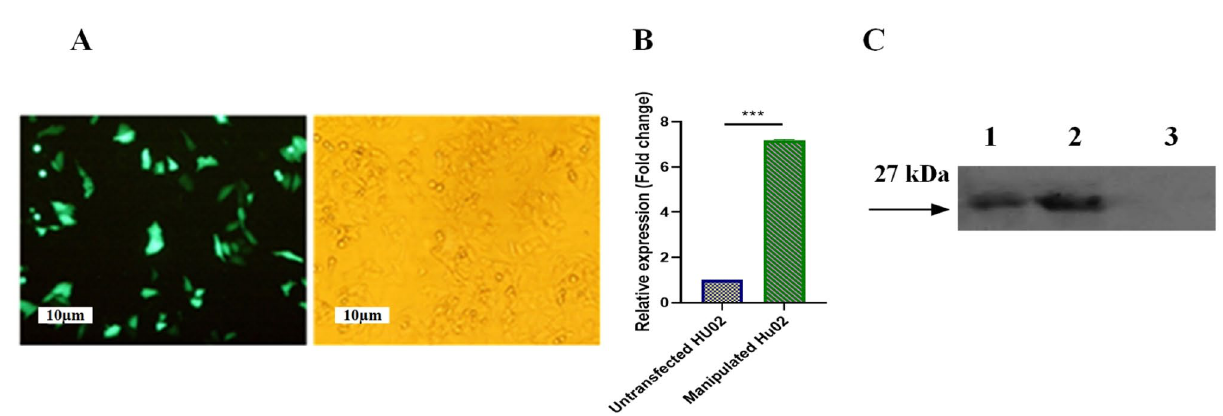
Figure 2. Schematic representation of the expression vector containing targeted gene used in this study and confirmation of VEGF gene by PCR and final approval of cloning by BamHI restriction enzyme. ( A ) pcDNA 3.1 (-) expression vector containing VEGF fragment downstream of the CMV promoter. ( B ) Agarose gel electrophoresis revealed that the PCR amplified target gene fragment was in the expected position, 620 bp of VEGF. ( C ) Cloning confirmation was done from the intermediate vector in the expression vector via BamHI restriction enzyme. Column 1: pcDNA 3.1 (-) containing VEGF vector cut with BamHI enzyme that cut fragment is 620 bp Column 2: The uncut pcDNA 3.1 (-) containing VEGF vector. Column 3: 1 Kb molecular weight size marker (Thermos Fisher Scientifics, USA).